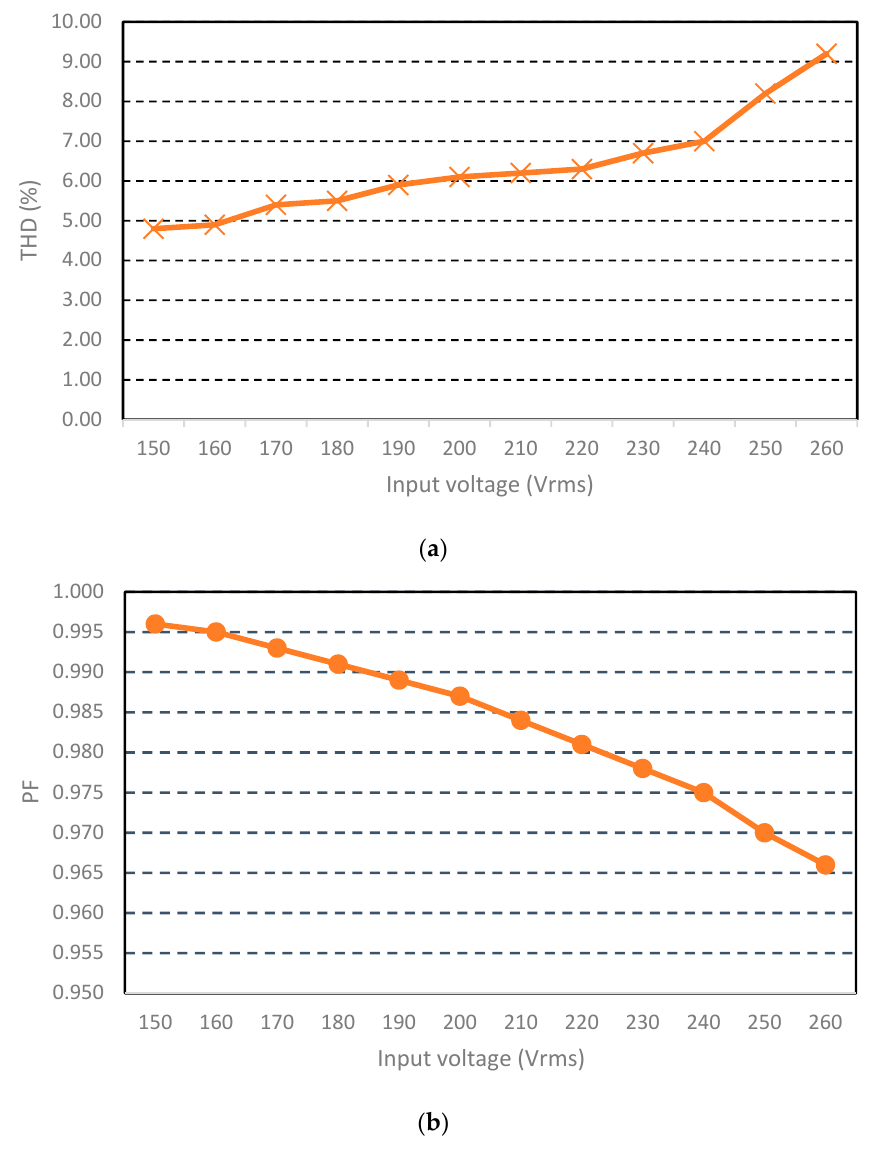
Figure 23. Experimental results of ( a ) PF and ( b ) THD with changing input voltage.